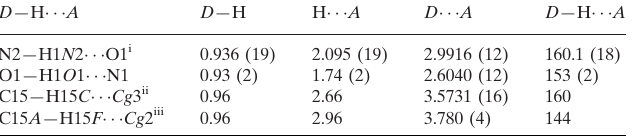
Hydrogen-bond geometry (A˚ , (cid:3)